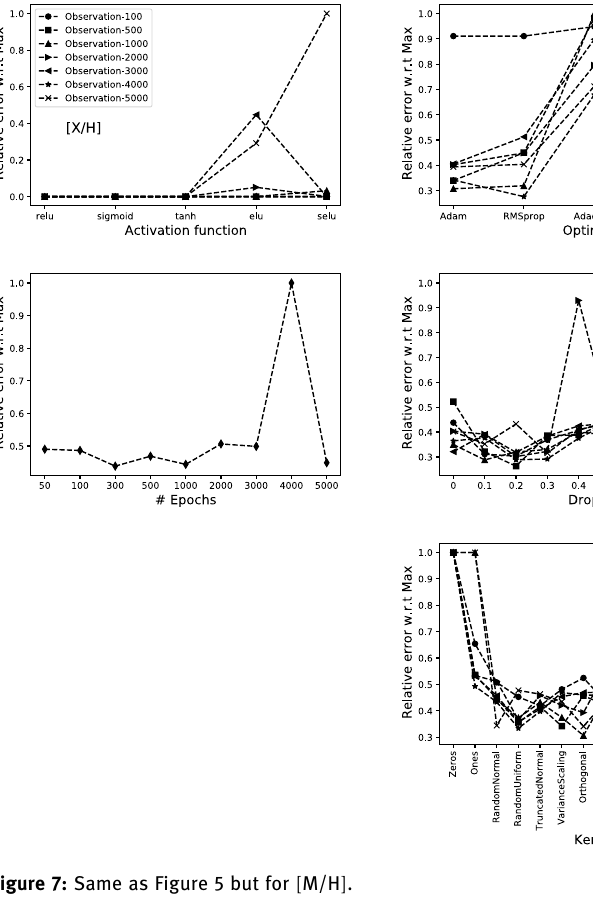
Figure 7: Same as Figure 5 but for [ M/H ]